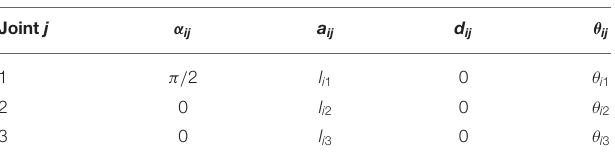
TABLE 3 | Denavit-Hartenberg